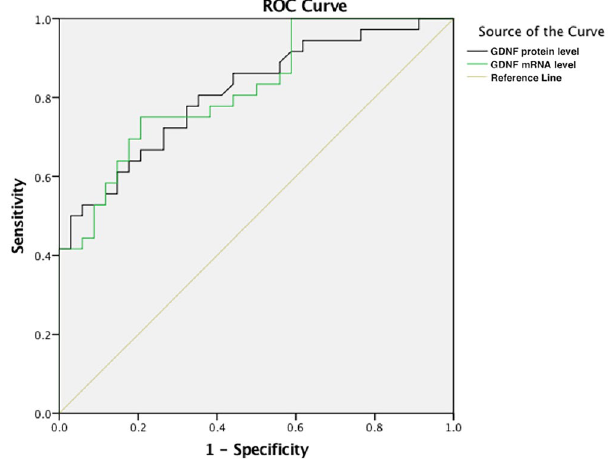
Figure 2. The results of ROC analysis in PSD and MDD groups indicated that the protein and mRNA levels of GDNF could serve as general distinguishing models with the AUC at 0.797 (95% CI, 0.696~0.898, P < 0.001) and 0.831 (95% CI, 0.744~0.918, P < 0.001) respectively. Abbreviations: ROC, receiver operating curve; PSD, post stroke depression; MDD, major depressive disorder. GDNF, glial cell line-derived neurotrophic factor; AUC, area under the